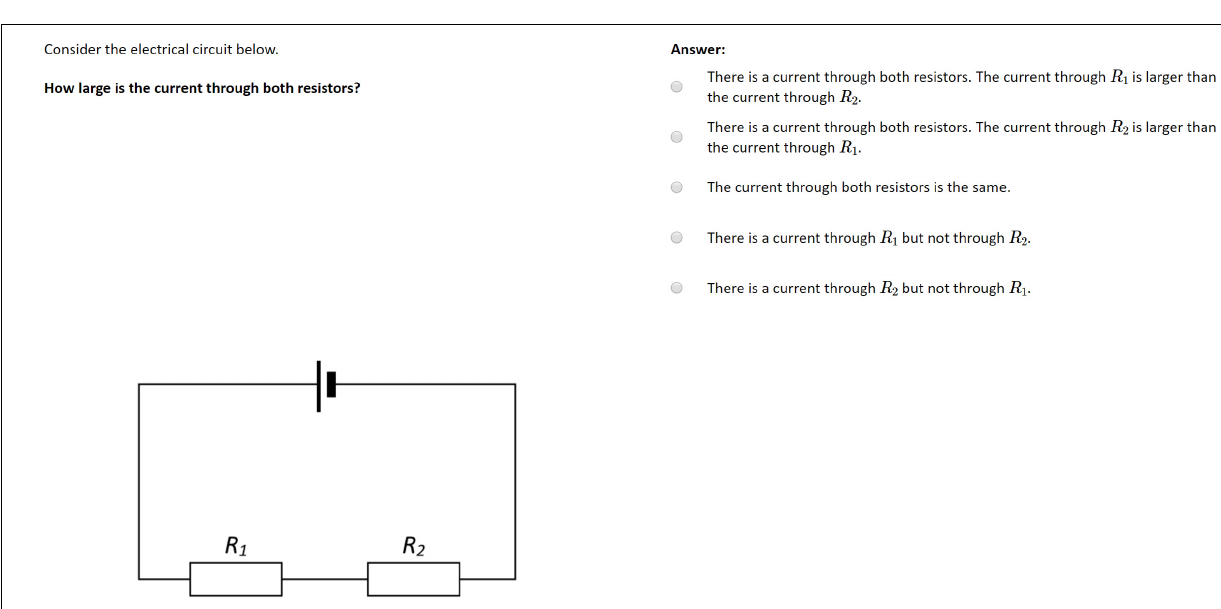
FIGURE 5 | Example of a conceptual knowledge item as presented to the participants (Urban-Woldron and Hopf, 2012; translated for this